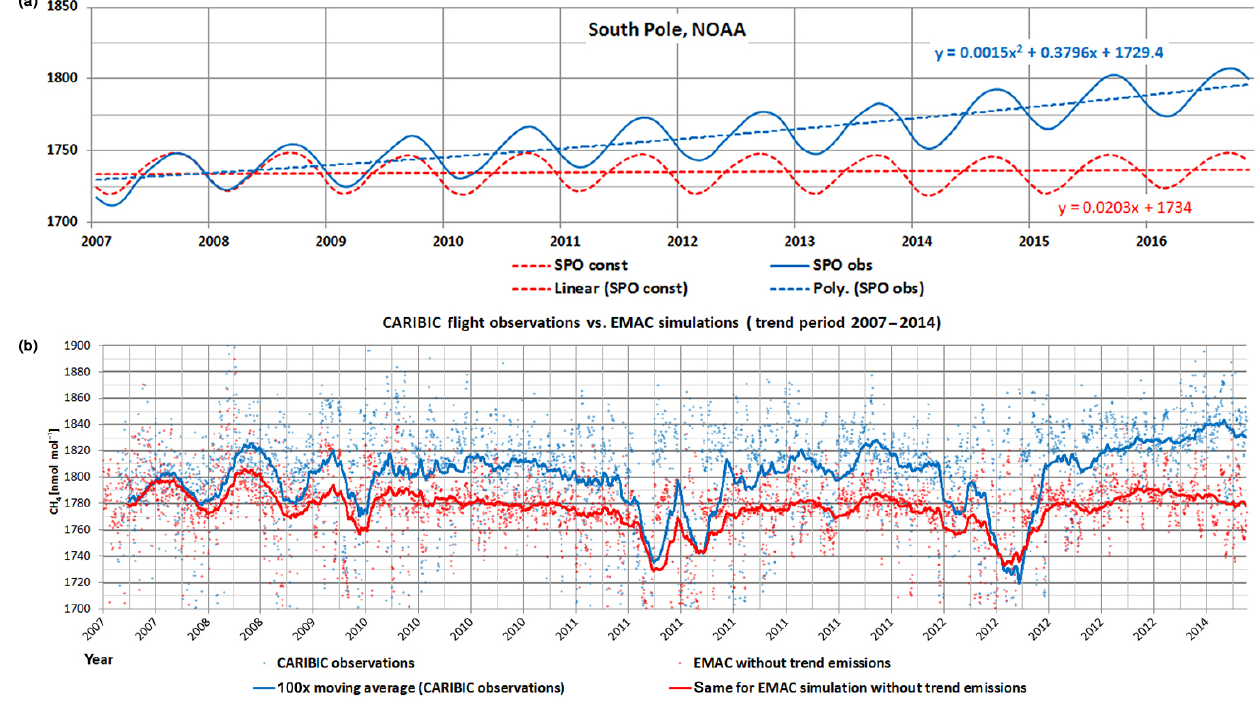
Figure 9. (a) NOAA observations at the South Pole (blue) from 2007 to 2016 compared to EMAC CH 4 calculations (red) under the 1997– 2006 unchanged emission assumption; units are in nmolmol − 1 . The observed trend is no longer linear and increasing after 2013 (following a second-order polynomial trend line, dashed blue). (b) CARIBIC flight observations (blue dots) compared to respective EMAC simulations without trend emissions (red dots); units are in nmolmol − 1 . Superimposed lines represent respective 100 × sliding means for better visibility. Table 3. Statistical evaluation of rising-methane scenarios. RMSD from all-station observation mean in nmolmol − 1 CH 4 .